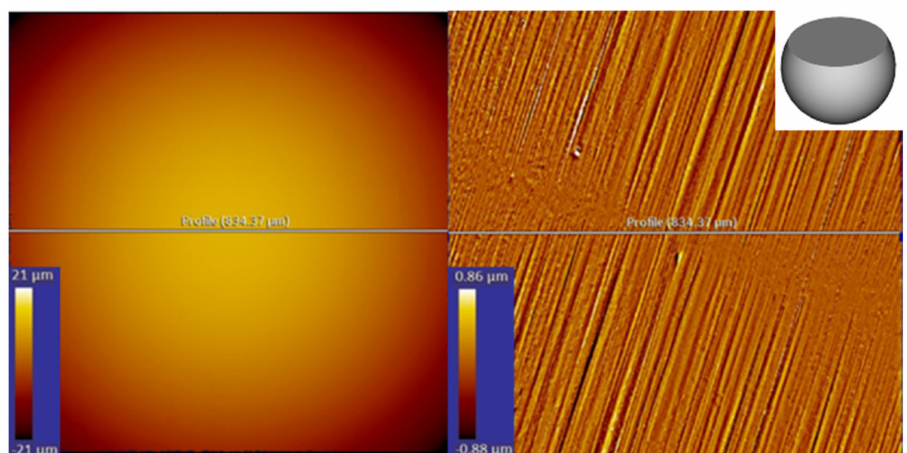
Figure 4. Surface topography of an untreated, spherical counterbody with a surface quality of G20 ( left ) and a counterbody after being used in a tribological experiment ( right ).